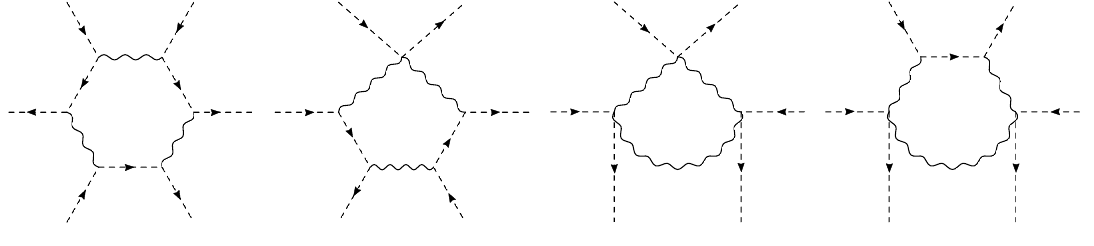
Figure 15 . Diagrams contributing to